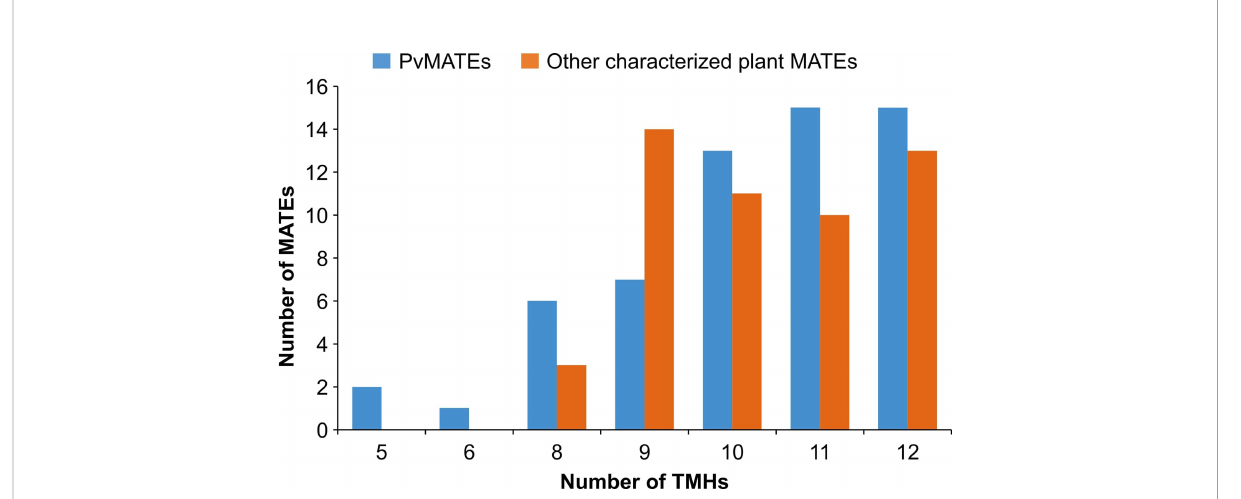
FIGURE 2 Number of predicted transmembrane helices in 59 candidate PvMATEs and 51 other characterized plant MATEs. Transmembrane helices predictions were performed using TMHMM v